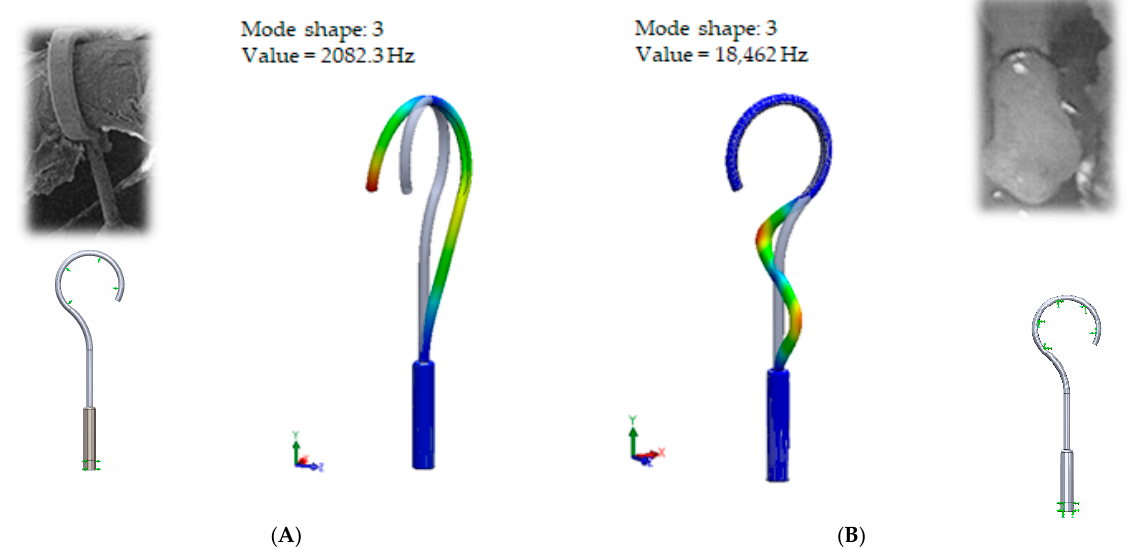
Figure 6. The results of modal analysis of fixing the standard stapes prosthesis on the incus long process and in cochleostomy. ( A ) target constraining of prosthesis, ( B ) over-constraining of the pros- thesis.